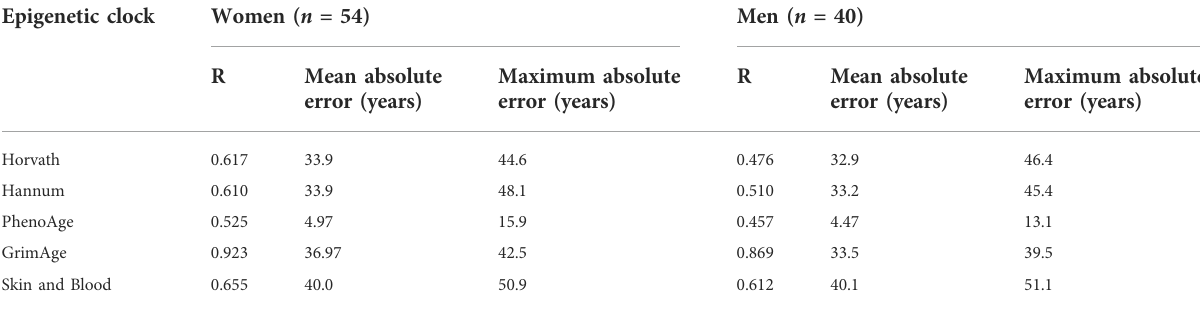
TABLE 2 Pearson ’ s correlations ( r ), Mean Absolute Error, and Maximum Absolute Error of the Horvath, Hannum, PhenoAge, GrimAge, and Skin and Blood epigenetic clocks in Men and Women from the Mediterranean Blue